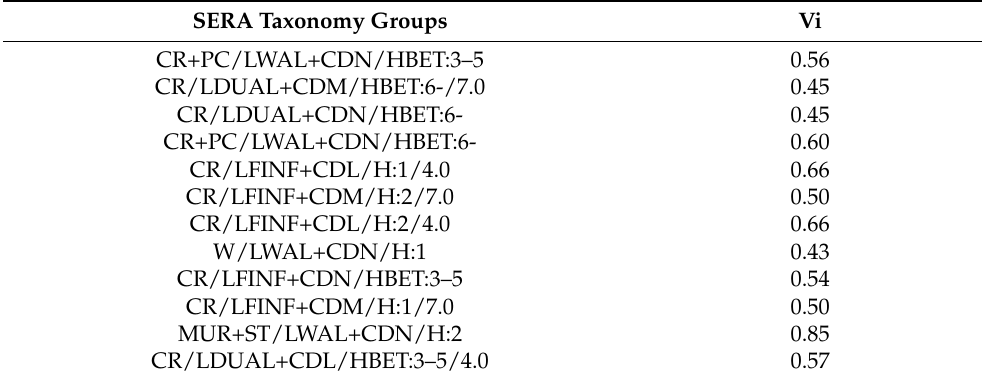
Table 3. The vulnerability index for the different taxonomy groups defined in SERA